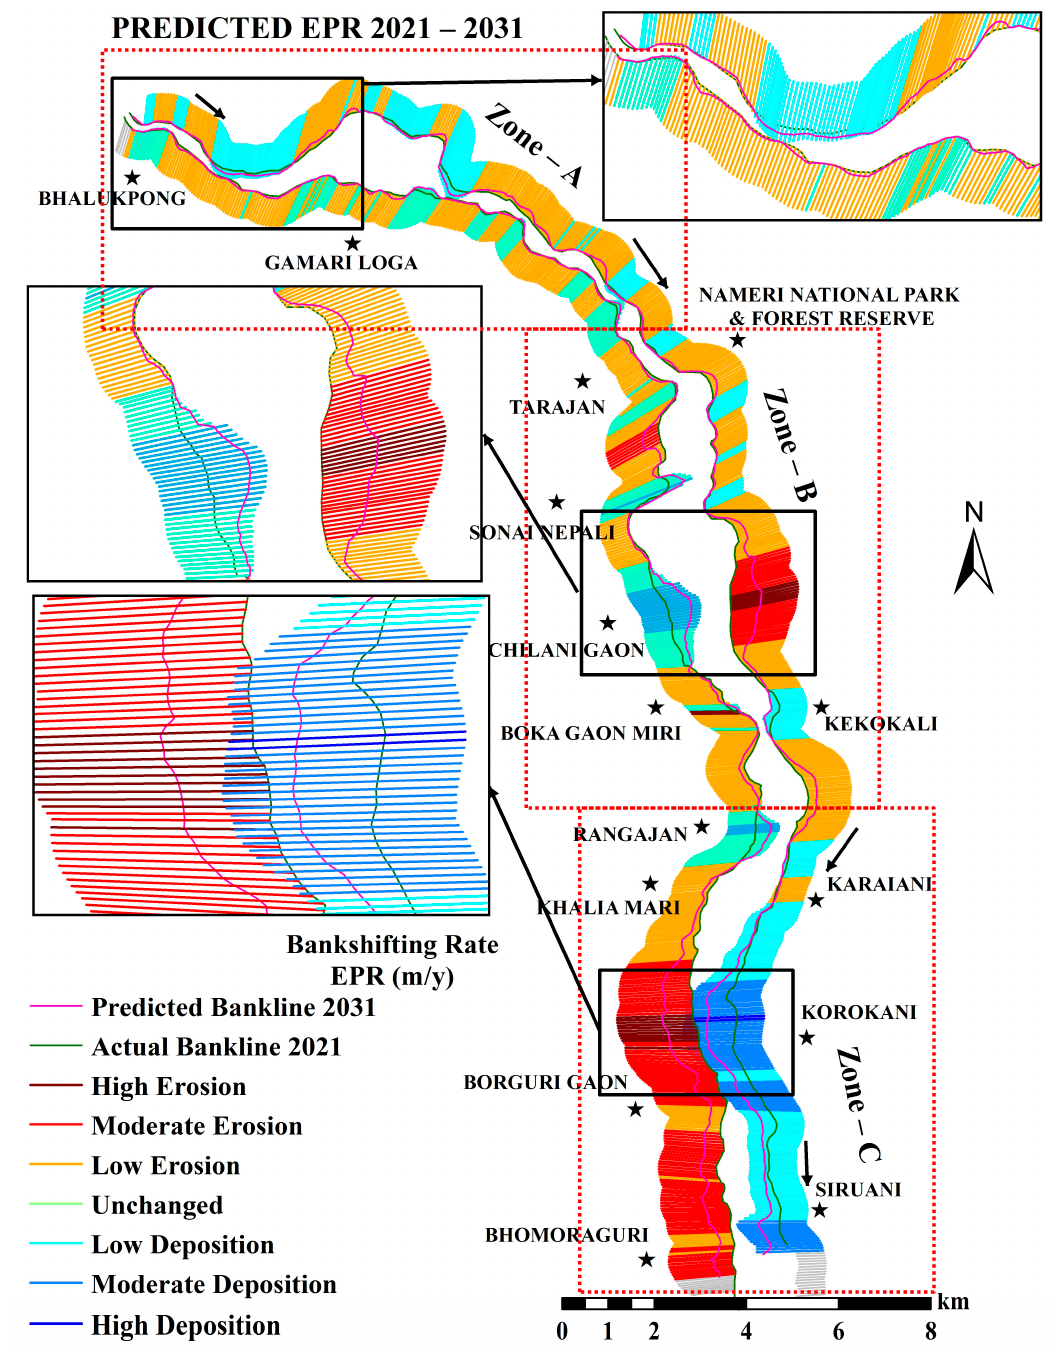
Figure 8. Spatial distribution of erosion and deposition (EPR-based) during the predicted period of 2021 to 2031.